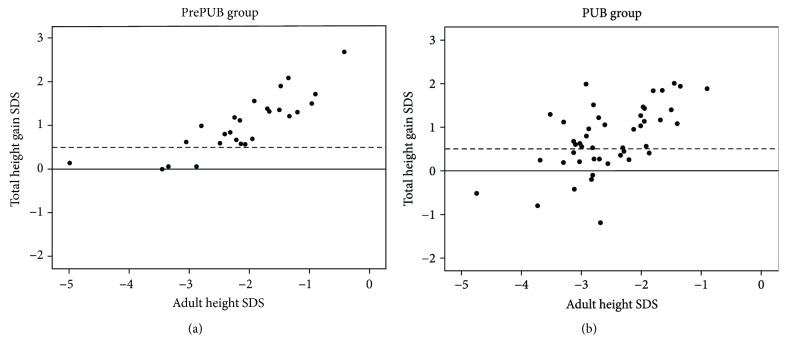
Scatterplot of total height gain SDS in relation to adult height SDS in the PrePUB group (a) and the PUB group (b).